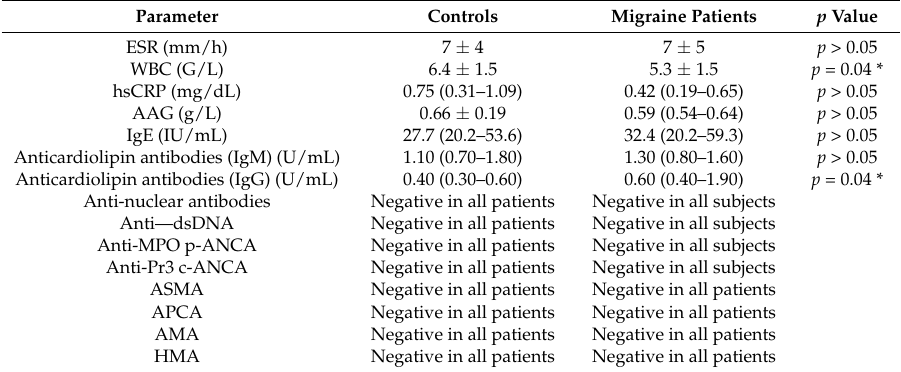
Table 1. Inflammation and autoimmunity markers in migraine patients and controls.